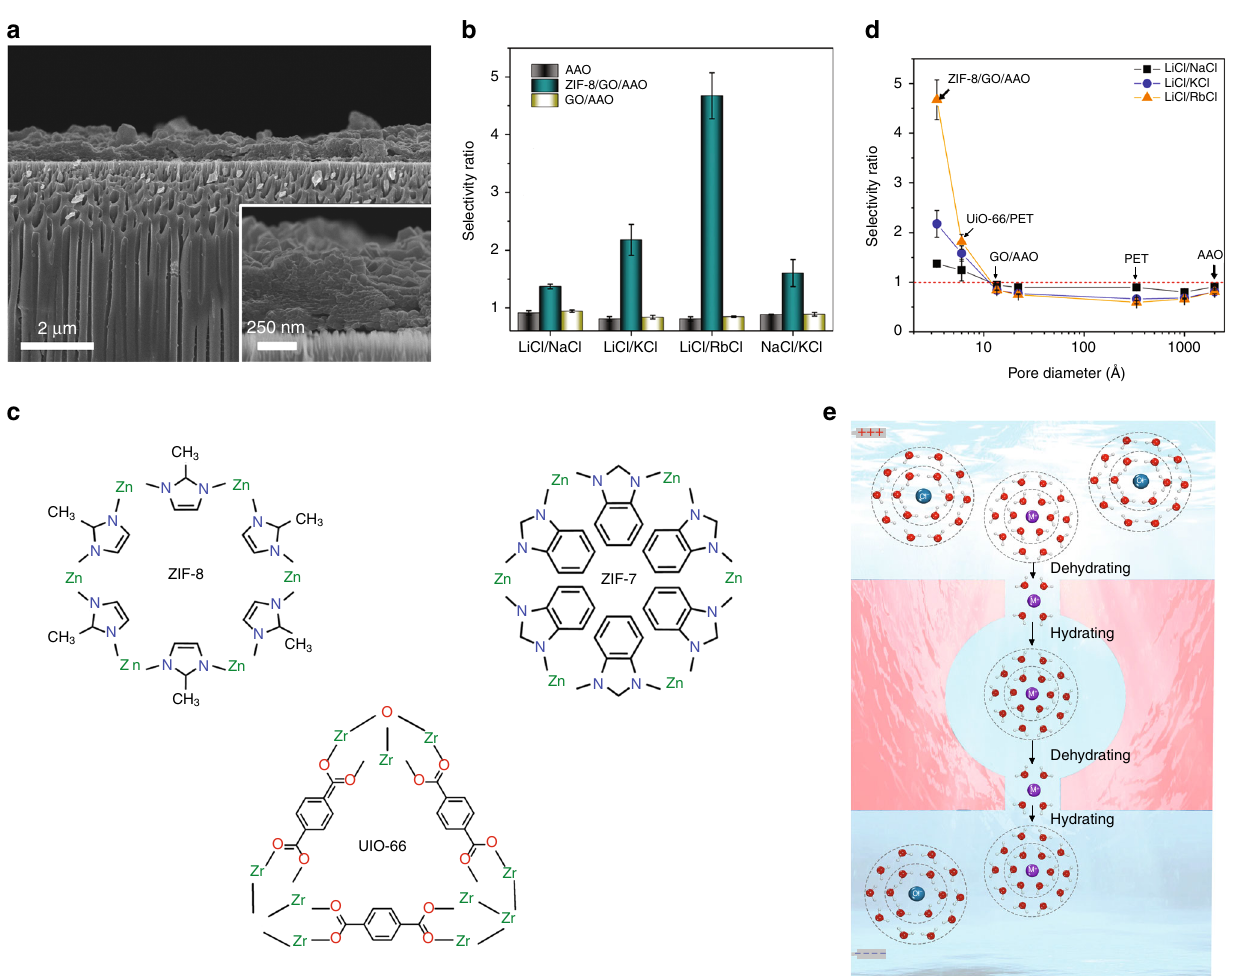
Fig. 3 Metal – organic frameworks as promising building blocks of Li-ion selective membrane. a The SEM image of ~446-nm-thick ZIF-8/GO layer grown on AAO support showing Li + / K + selectivity of 1.37. The inset shows that the layer is densely grown on the top of the AAO support. b Alkali metal ion selectivity of AAO, ZIF-8/GO/AAO, and GO/AAO membranes. Error bars represent the range of measurements of selectivity over the many events. c The molecular structures of ZIF-8 with ~3.4 Å window, ZIF-7 with ~2.9 Å window, and UiO-66 with ~6.0 Å window. d Ion selectivities as a function of the pore window diameter of different MOFs and of the pore diameter of nanoporous membranes. The fi gure shows that at the subnanometer scale, the alkali metal ion selectivity of the MOF membranes decreases with increasing window diameter (no alkali metal ion selectivity was observed for membranes with pore diameters >1 nm). e Li + ions passing through sub-nanometer ZIF-8 pore experience multiple dehydration – hydration processes (spheres: blue = Cl − , purple = monovalent cations that are surrounded by H 2 O molecules. “ + ” sign is Cathode while “–” sign is Anode), reproduced from ref. 51